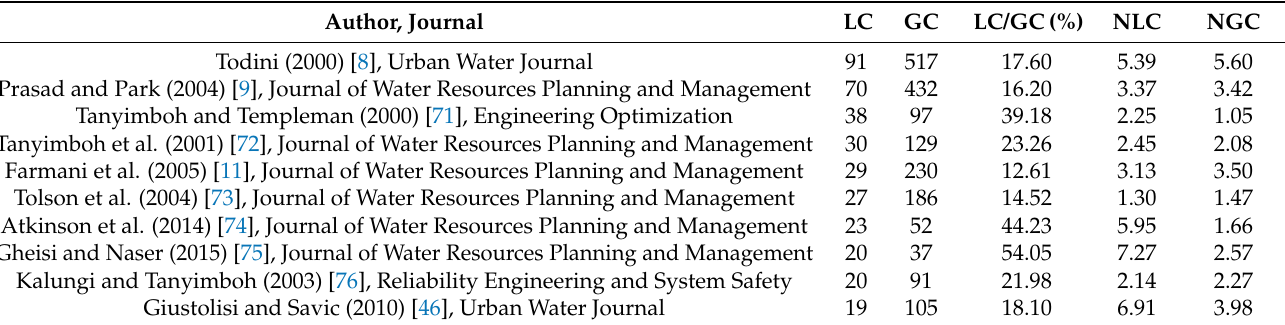
Figure 4. Citation network of articles: the node size represents citation number; the link between different nodes represent the collaboration between them; the distance between nodes represents the association between them in terms of co-citation. Table 1. Top ten articles with highest number of citations.